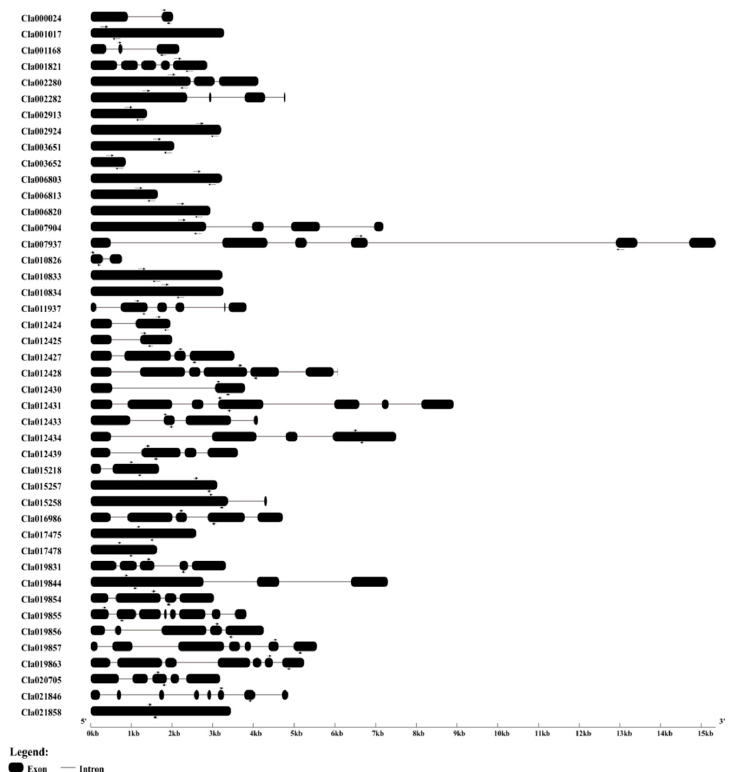
Figure 2. Exon–intron structures of the 44 NBS-encoding R genes from watermelon. Rectangles and gray lines indicate exons and introns, respectively. Left and right arrows indicate position of forward and reverse primers, respectively.